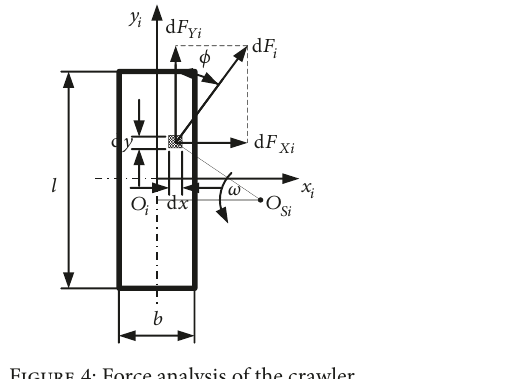
Figure 4: Force analysis of the crawler.